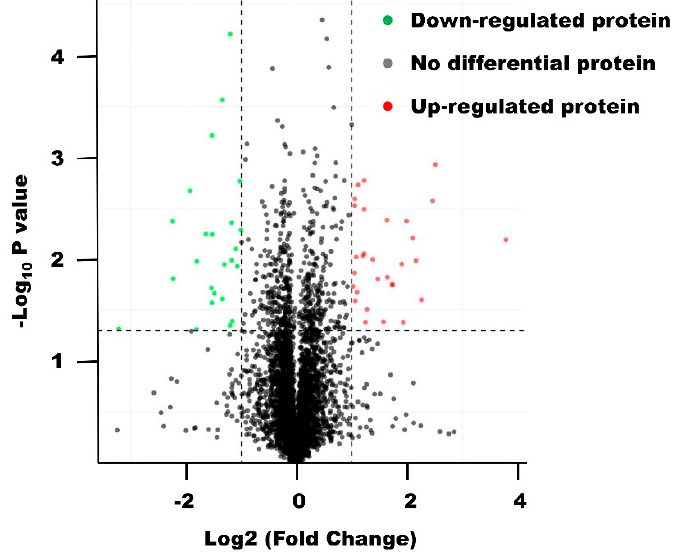
Figure 2. Volcano plot of proteins in SU-DHL-2 cells treated with EEP versus control groups. The subcellular localization results of the differential proteins showed 32.47% nucleus protein, followed by 20.78% cytoplasm protein, 14.29% mitochondrion protein, 6.49% lysosome proteins, 6.49% endoplasmic reticulum protein, 3.9% plasma membrane protein, 3.90% Golgi apparatus protein, 3.90% extracell protein, 3.90% cytoskeleton protein, 1.30% microsome protein, 1.30% endosome protein, and 1.30% centrosome proteins.